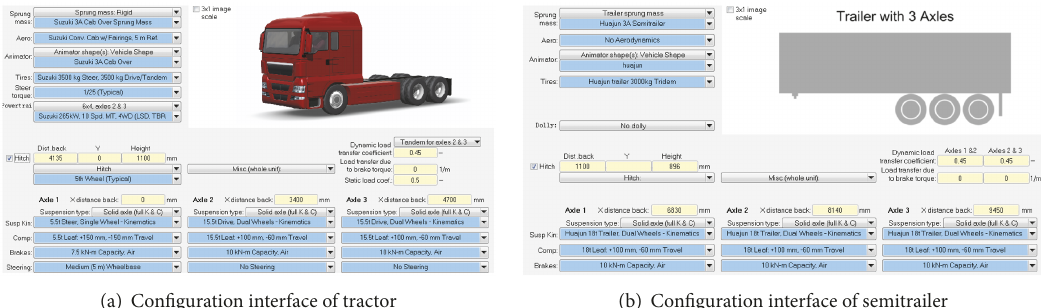
Figure 1: Vehicle configuration interfaces in TruckSim.